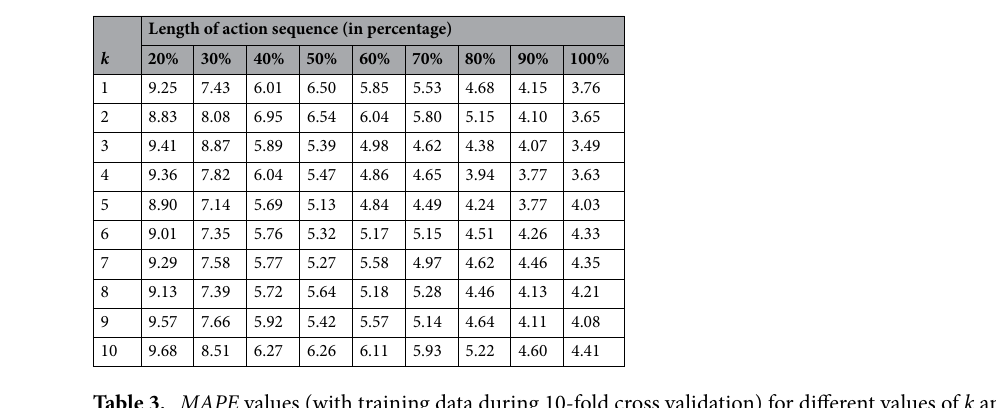
Table 3. MAPE values (with training data during 10-fold cross validation) for different values of k and length of action sequence (in percentage).